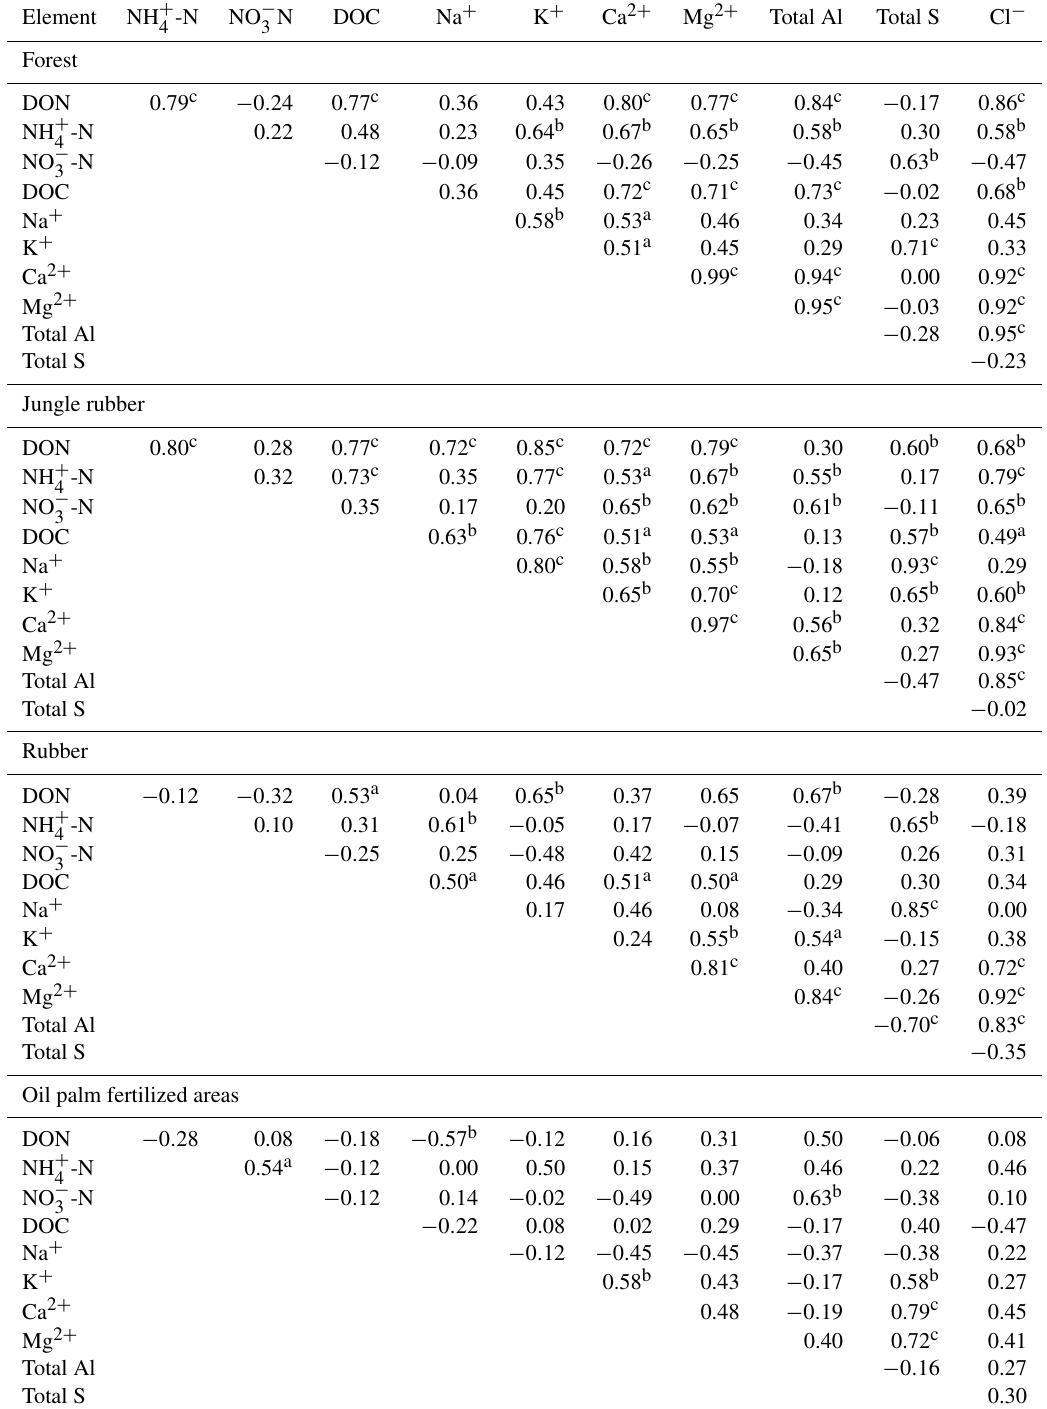
Table A3. Pearson correlations among element concentrations (mgL − 1 ) in soil solutions from a depth of 1.5m in different land uses within the loam Acrisol soil in Jambi, Sumatra, Indonesia. Correlations were carried out using monthly averages of four replicate plots per land use ( n = 12 monthly measurements in 2013). Elements that had concentrations <0.03mgL − 1 (total Fe, total Mn, and total P) and total Si that did not show correlation with other elements are not reported